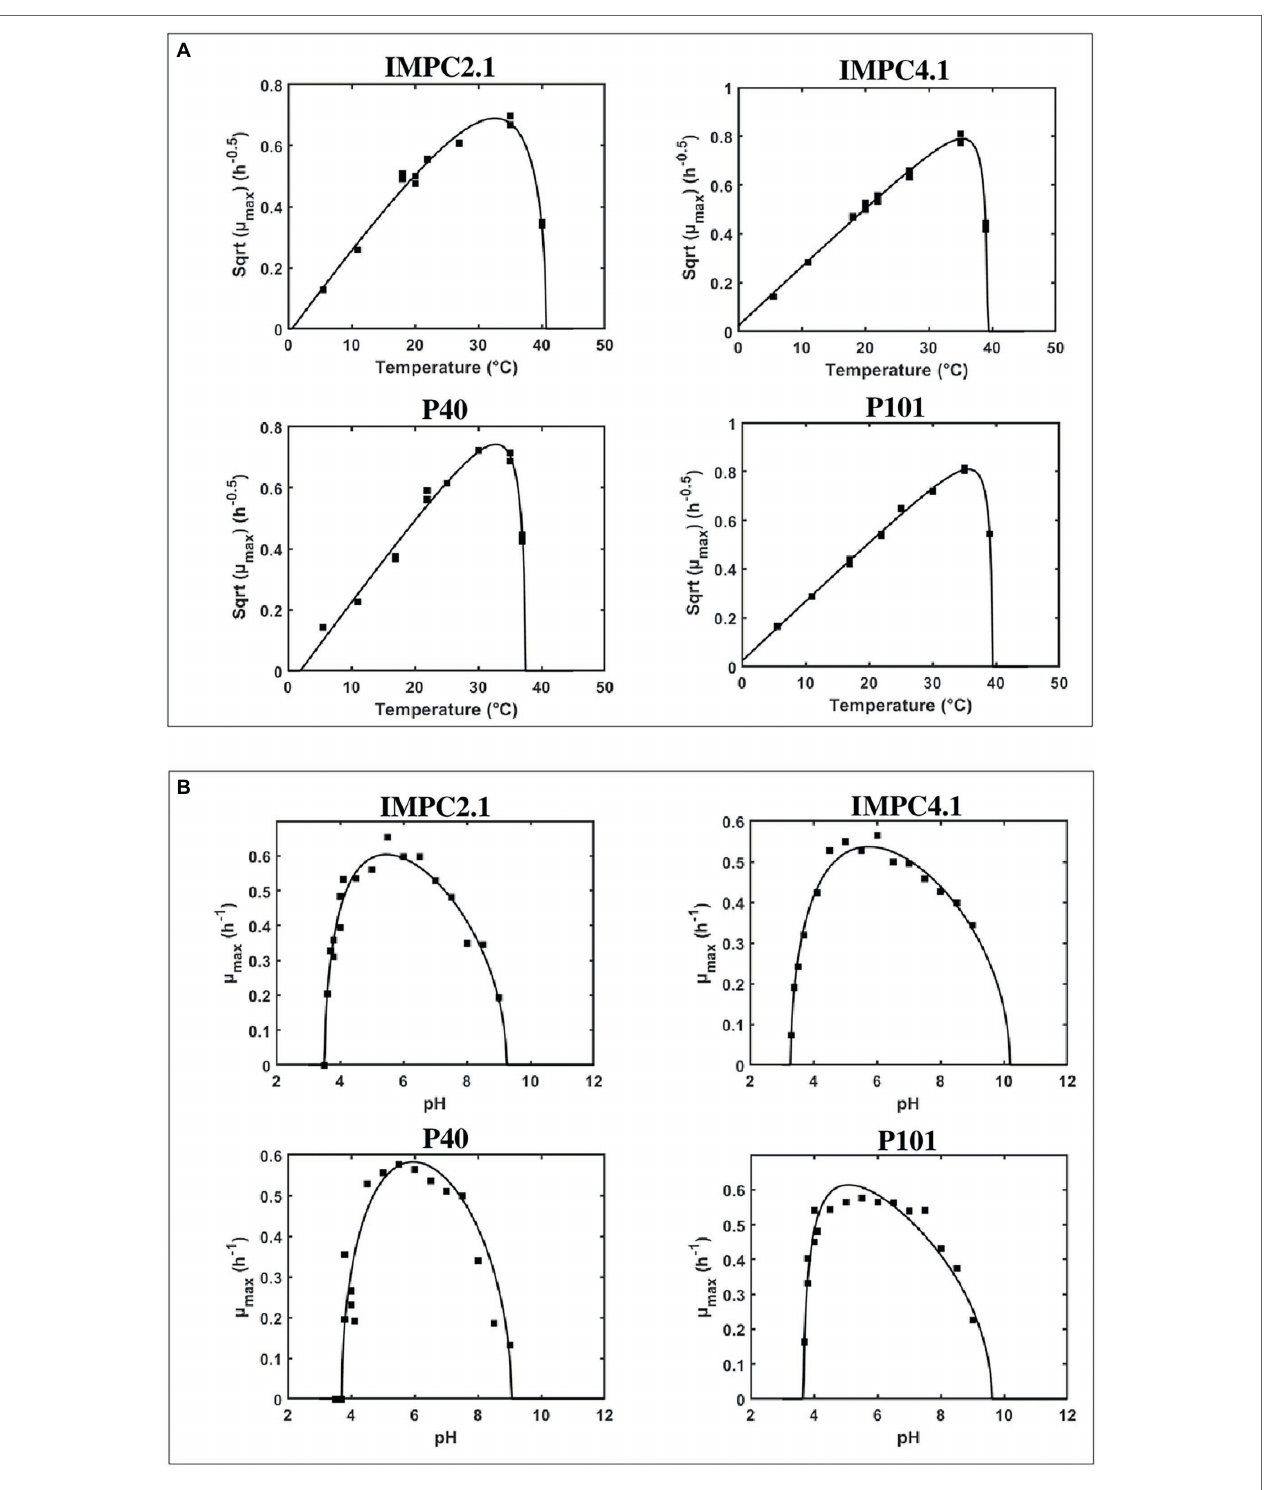
FIGURE 1 | Effect of temperature (A) and of pH (B) on the maximum specific growth rate ( μ max ) of different strains of Lacticaseibacillus paracasei . Comparison between the fitted model and observed maximum specific growth rates ( ■